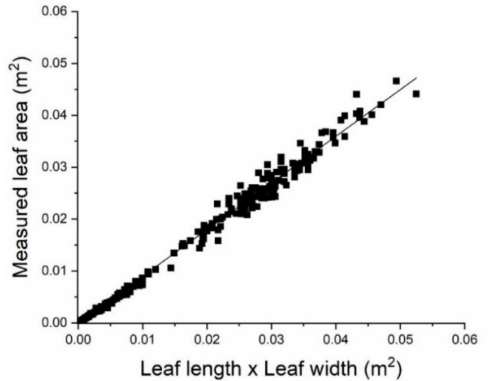
Figure 2. The relationship between leaf area and the product of leaf length measured along the mid rib and maximum leaf width of Actinidia chinensis var. chinensis ‘Zes008’ leaves, n = 240. Leaf area = 0.899(L × W), r 2 =